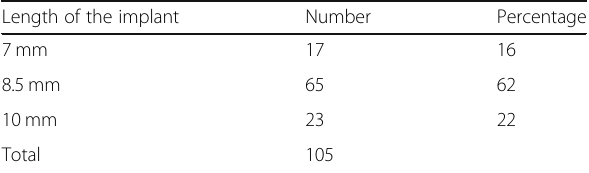
Table 3 Implant length and insertion distribution Length of the